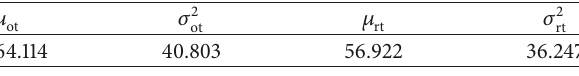
Table 2: Normal distribution parameters.